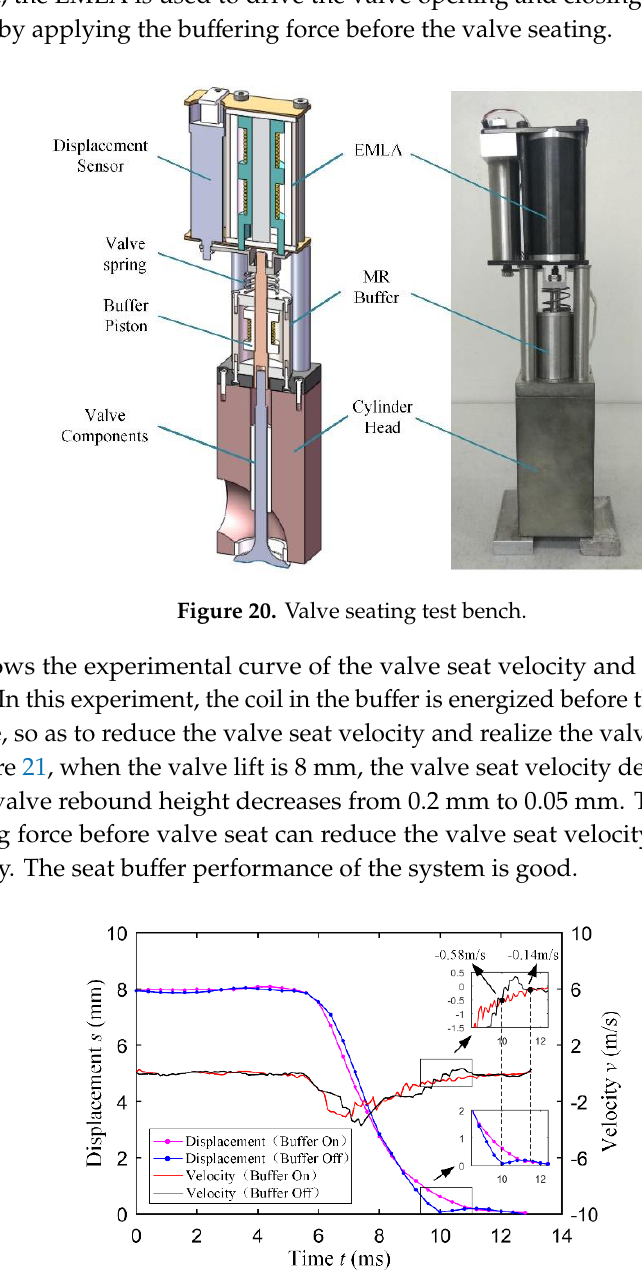
Figure 21. Experimental result of seating performance when the valve lift is 8 mm.